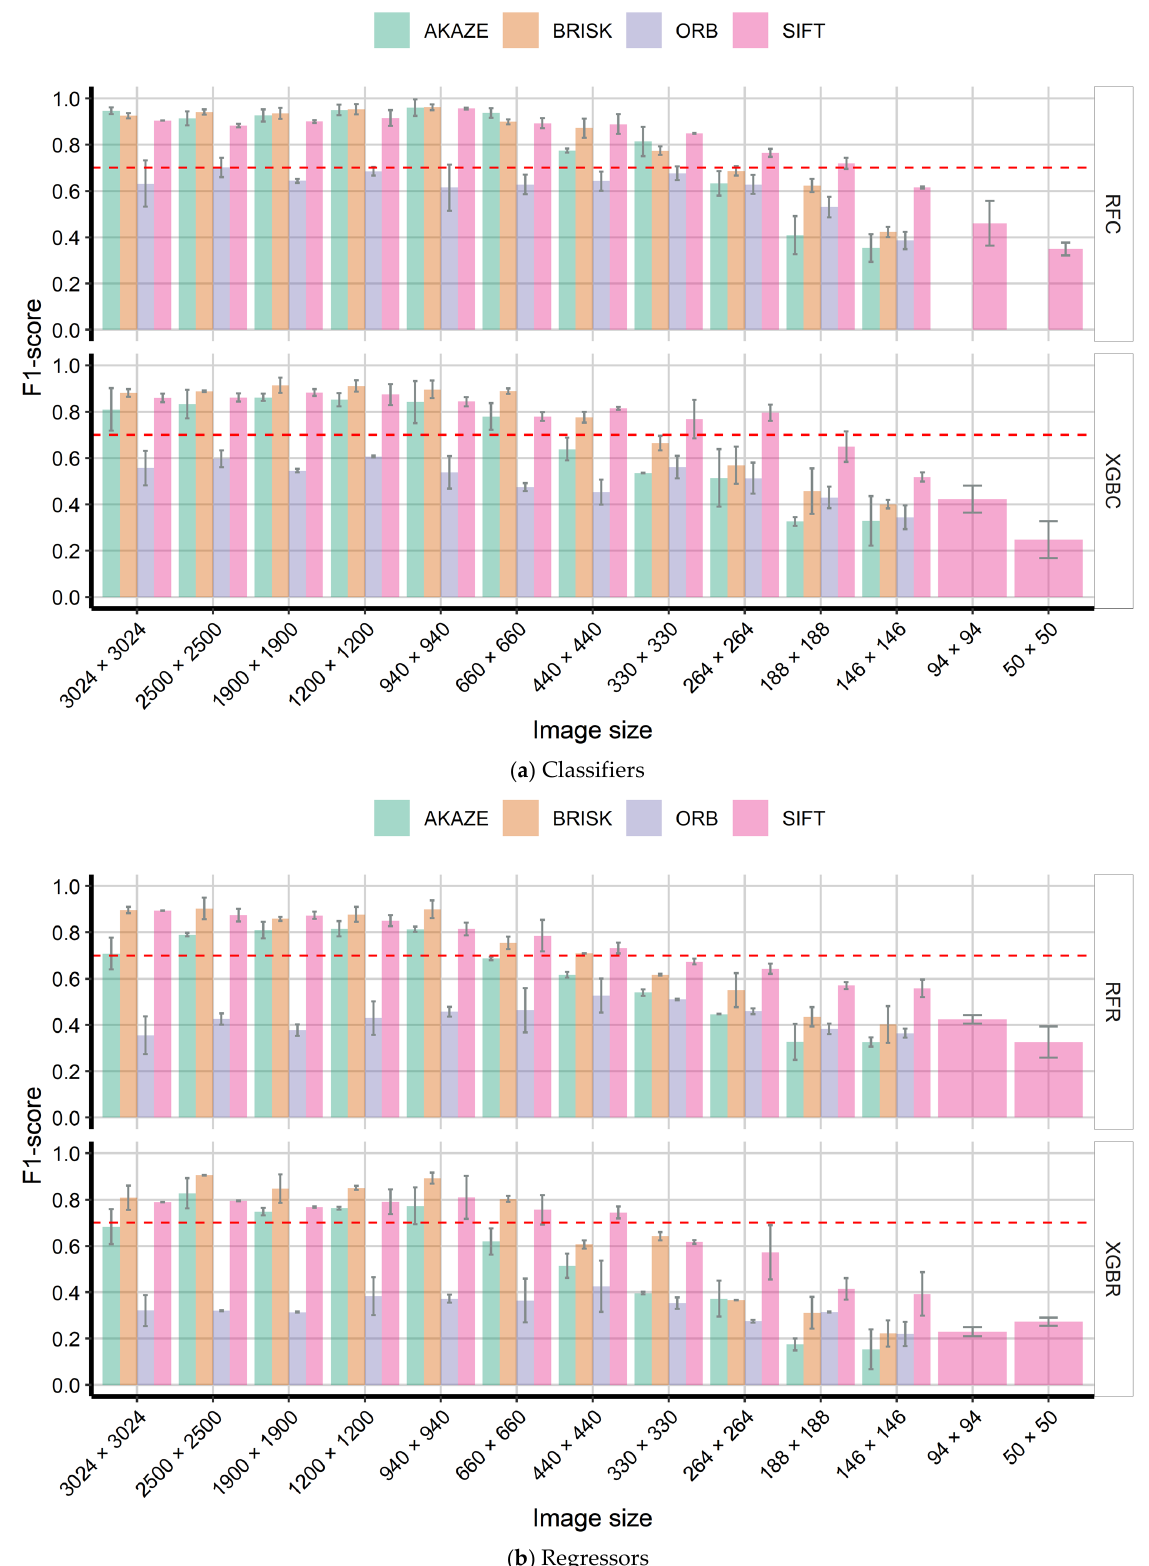
Figure 11. F1-score performance in local descriptors when cropping the images in G03. The local features were also evaluated with cropped images in the same way as the global descriptors in Table 3. Handling these features requires more computational re- sources and time for training; however, the results indicate a better performance for deter- mining the different levels of humidity. The reported f1-score values were over 0.9 for BRISK, SIFT, and AKAZE local descriptors. In addition, a one-way ANOVA test was also performed, and a p -value of 0.00114 was obtained. This demonstrates again that there are statistically significant differences between the algorithms. Table 3. F1-score over the local features with the BOWN technique. Local Descriptors